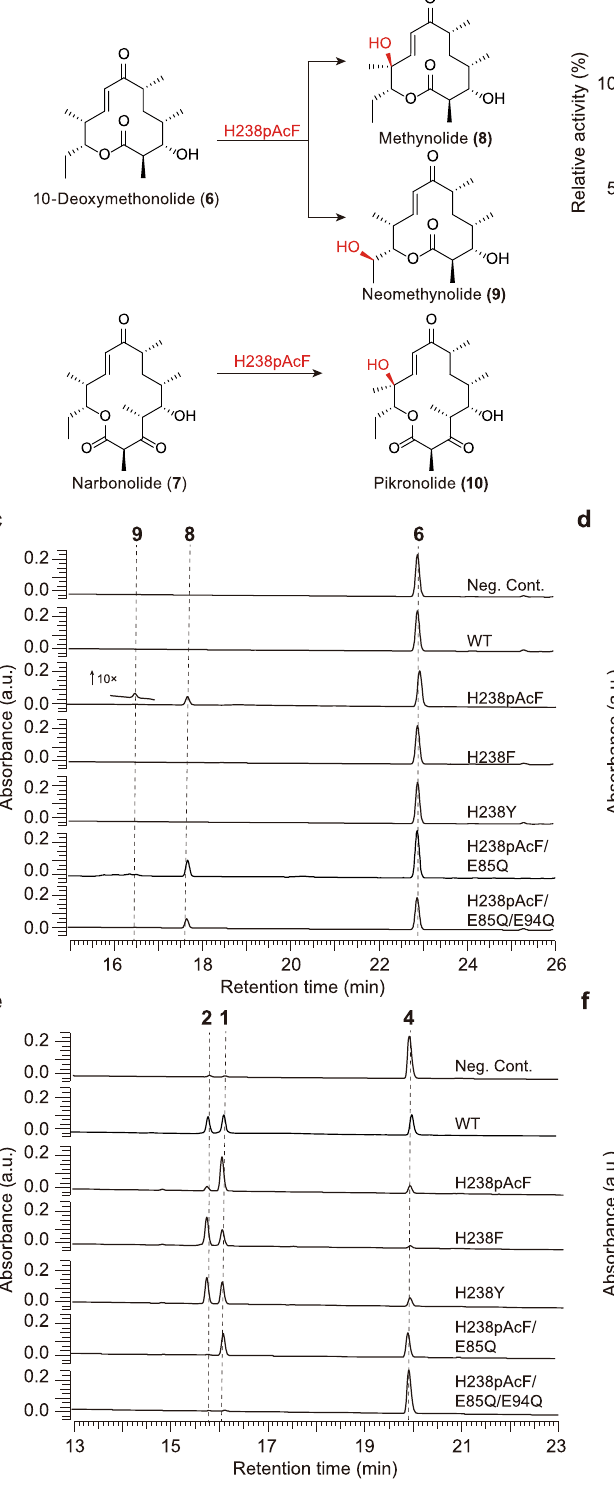
Fig. 3 | Functional analysis of PikC mutants. a The scheme of PikC H238 p AcF cata- lyzedaglyconehydroxylationreactions. b Therelativeactivitiesofthemutantswith His238 replaced by different ncAAs towards 6 and 7 . Data are presented as mean values±SEM. Black diamond-dots represent individual data points for n = 3 replicates. Statistical analysis was performed using the Student ’ s t test (two-tailed; * P <0.05, ** P <0.01). c – f , HPLC analysis (230nm) of the enzymatic reactions